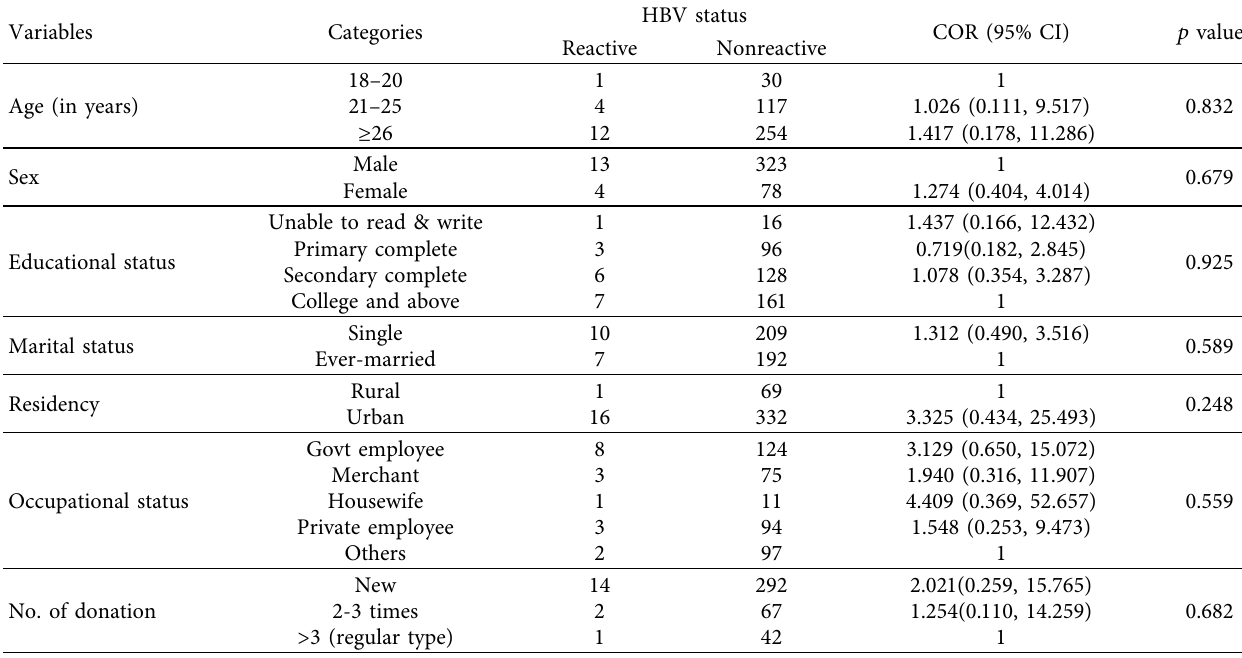
Table 4: Bivariate analysis of HBV with sociodemographic characteristics of blood donors at Bahir Dar Blood Bank centre,